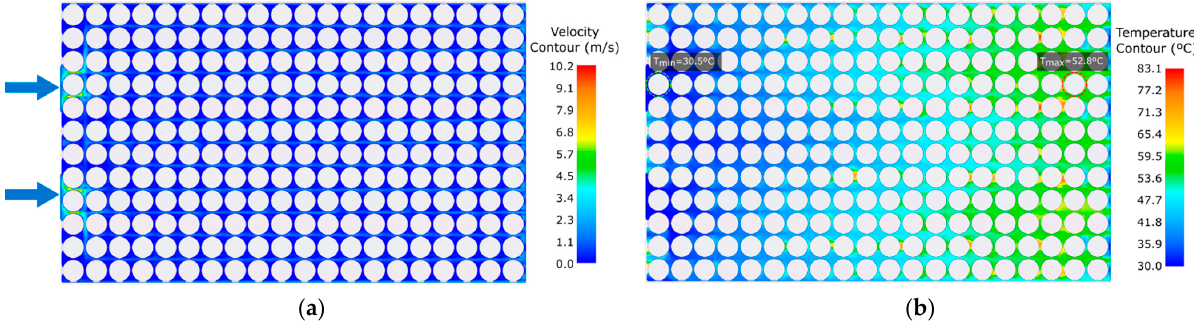
Figure 4. The contour of ( a ) velocity and ( b ) temperature of 2 inlet model.